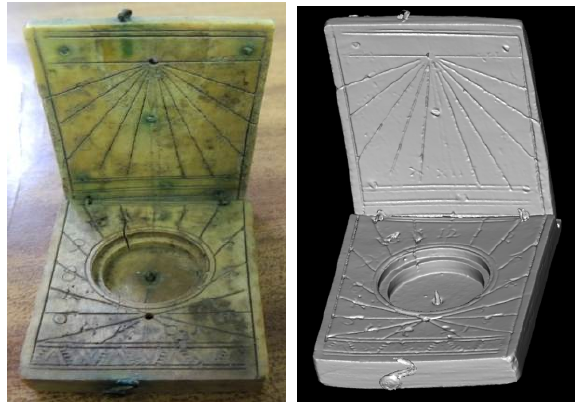
Figure 15. Picture and 3D model of the diptych travel sundial